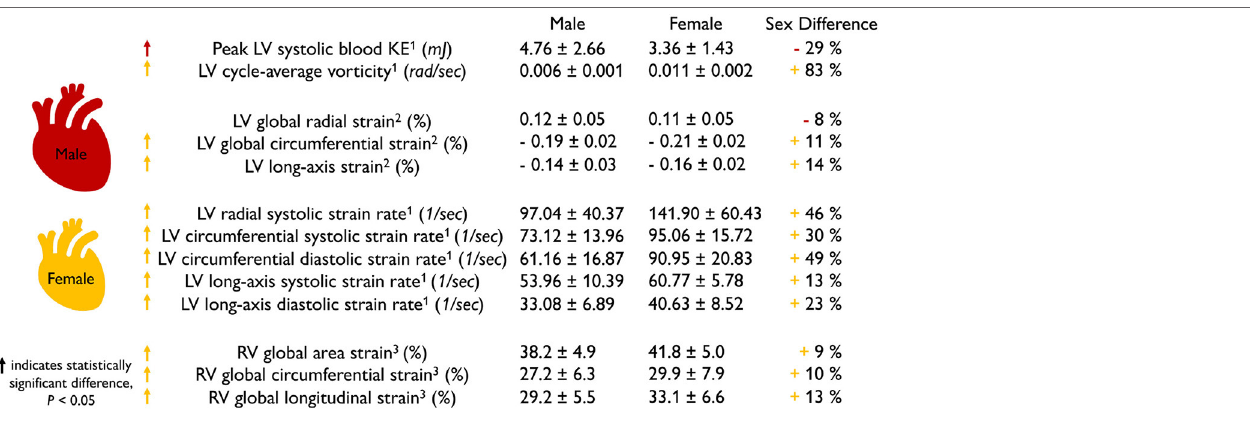
TABLE 2 | Sex differences in healthy myocardial